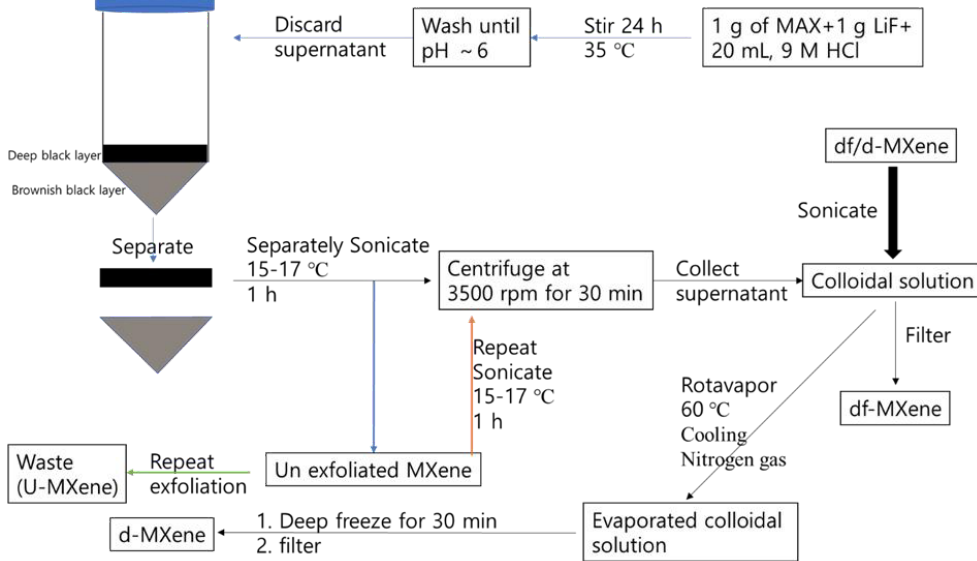
Figure 7. Flow chart of the synthetic approach of the exfoliated MXene synthesis [31] Copyright Royal Society of Chemistry, 2020.